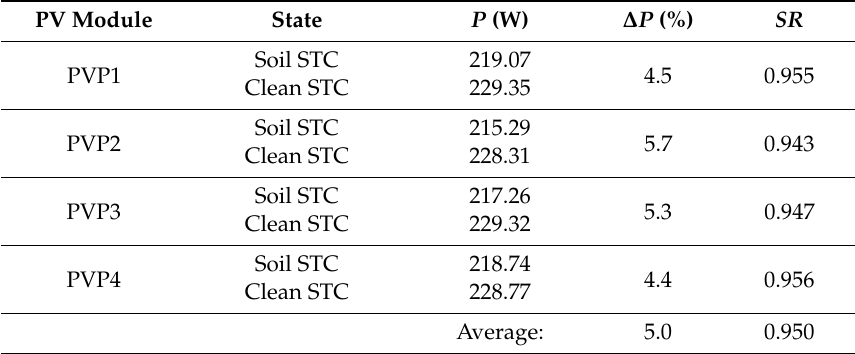
Table 3. The influence of soiling on the PV modules power.